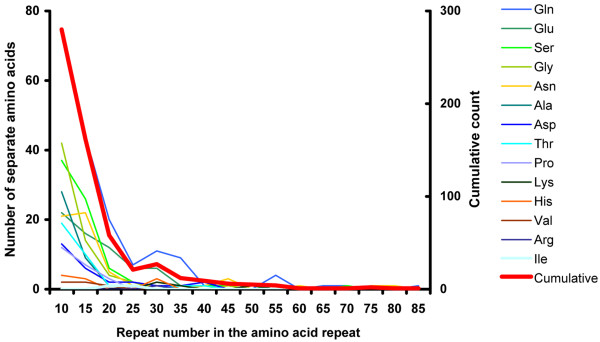
The distributions of the repeat lengths of the different types of amino acid repeats encoded by tri-nucleotide SSRs. The x-axis represents the length of amino acid repeat and the primary y-axis (left side) is the observed count of individual amino acid repeats in a given amino acid motif (thin lines) and the secondary y-axis (right side) is the observed count of all amino acid repeats combined (thick red line).